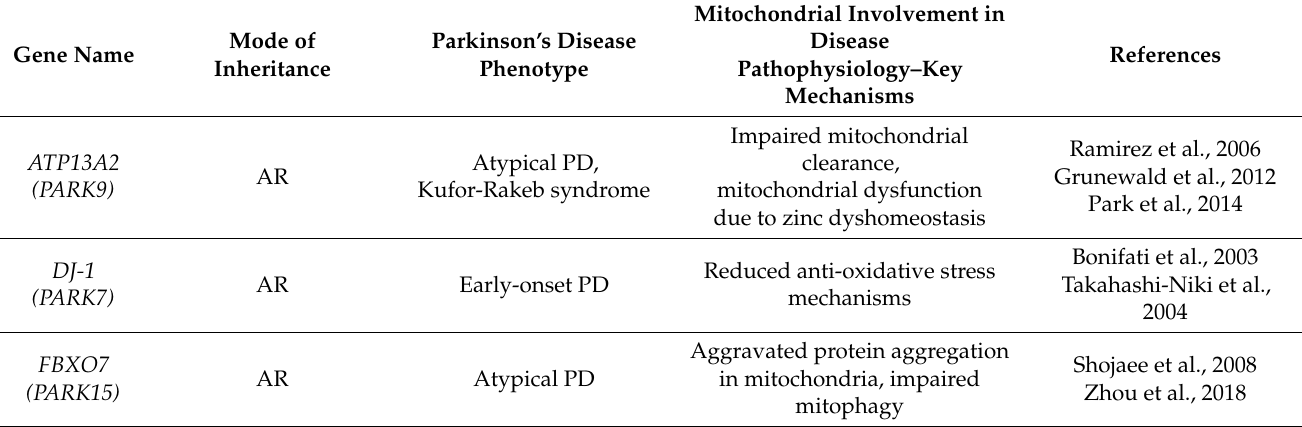
Table 1. Established causative genes of monogenic PD and their respective association with mitochondrial